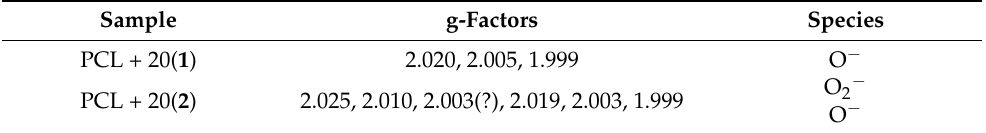
Table 5. EPR data for PCL + 20TOCs (TOCs = ( 1 ) and ( 2 )) composite samples. The samples were exposed to visible light prior to measurement.